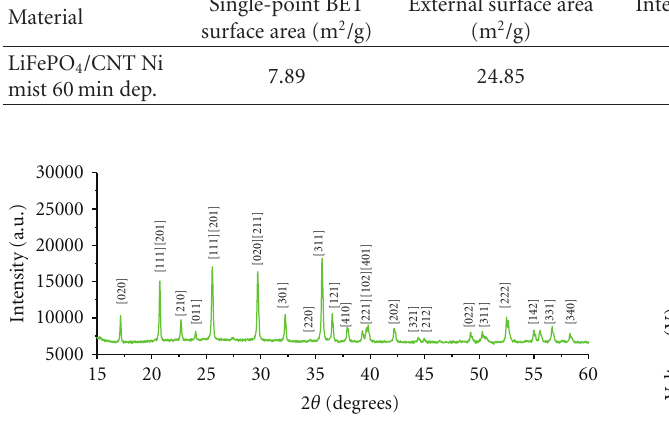
Table 2: Surface area and porosity data for the composite LiFePO 4 /CNT cathode material. Material